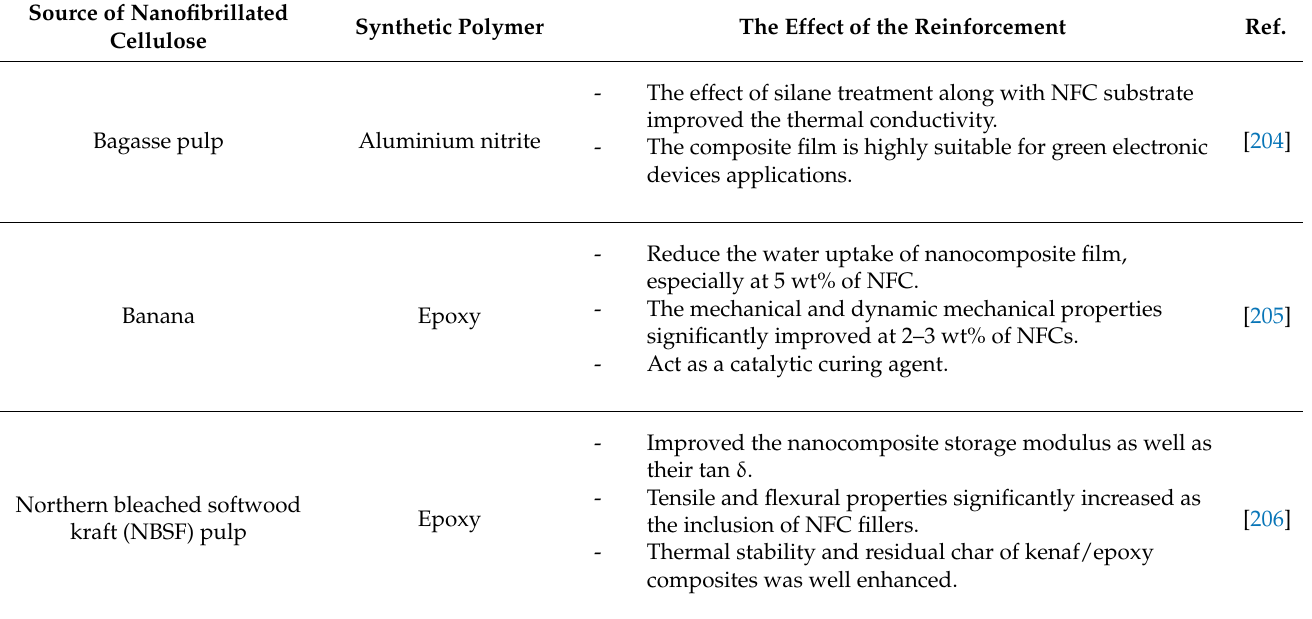
Table 2. Illustration of the effects of nanofibrillated cellulose on synthetic polymer matrix. Source of Nanofibrillated